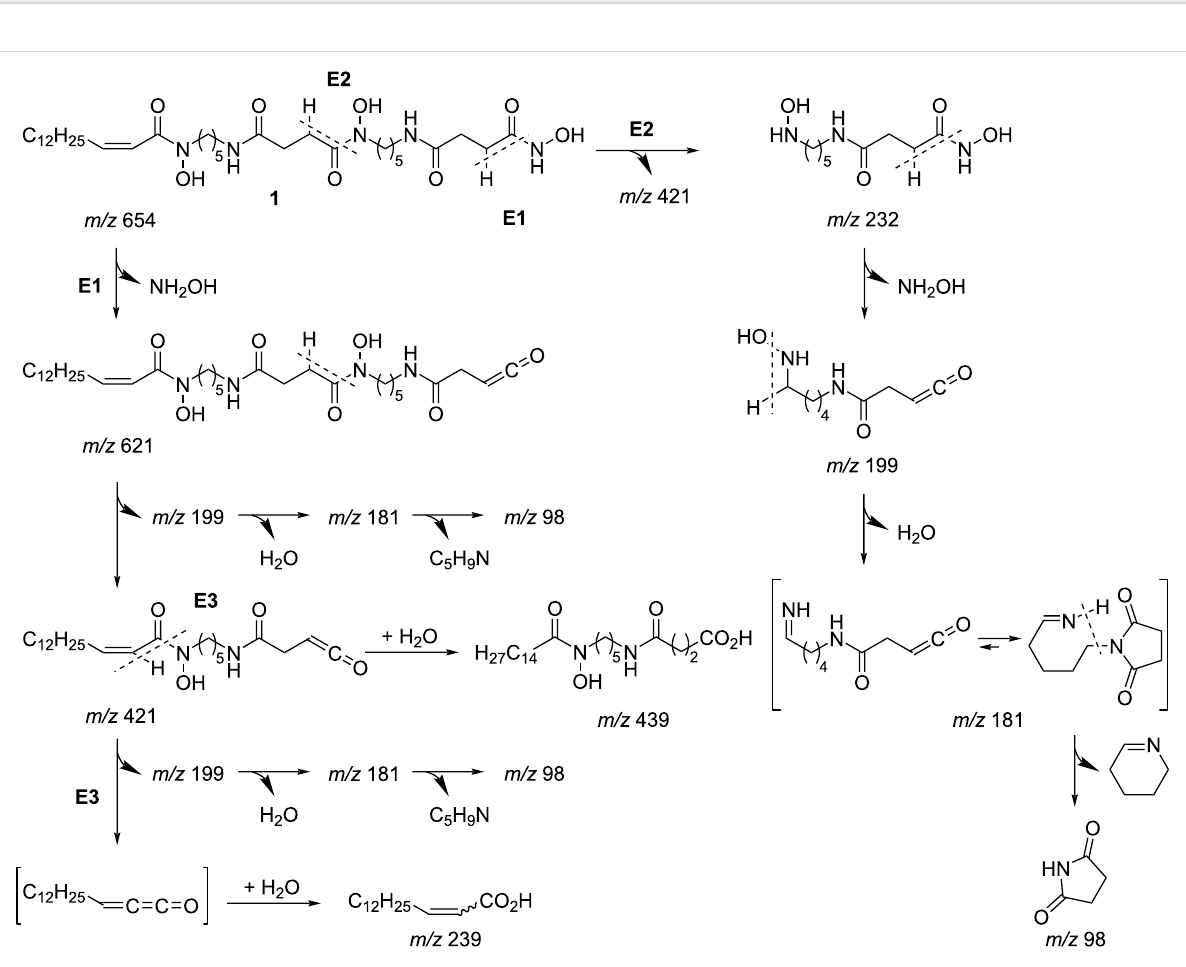
Figure 4: MS/MS spectrum of 1 acquired on a quadrupole time-of-flight mass spectrometer in the negative ion mode.